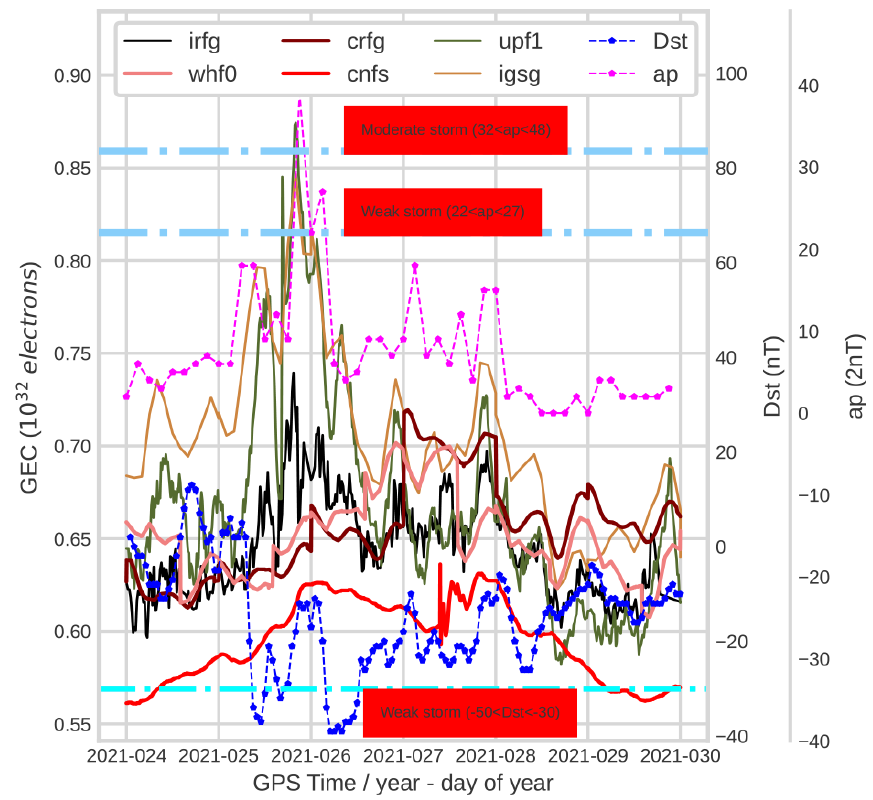
Figure 6. The GEC, ap and Dst evolution of RT-GIMs from 24 to 29 January 2021 during the low-solar-activity